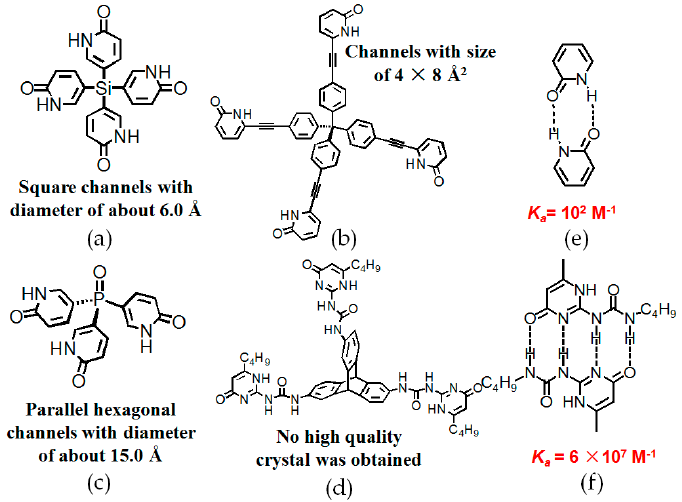
Figure 17. Structures of building motif 16 ( a ); 18 ( b ); 17 ( c ); and 19 ( d ); ( e ) dimeric 2-pyridone array; ( f ) dimeric UPy array.